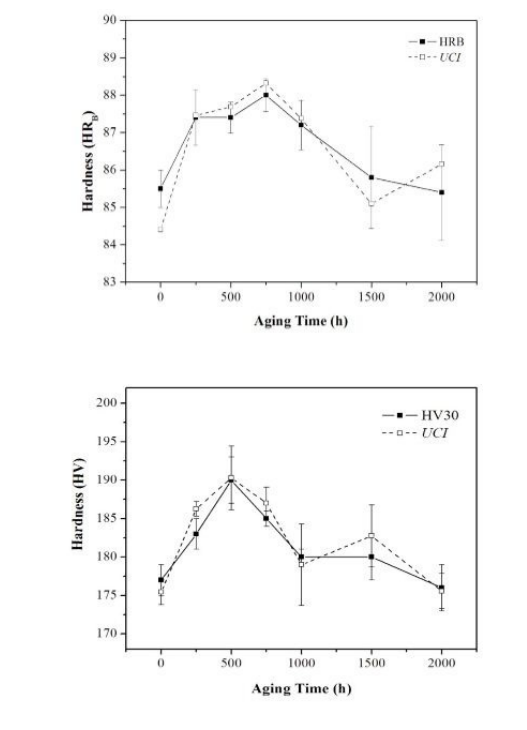
Figure 3. Comparison between Rockwell B and Vickers laboratory and field hardness values of solution treatment and isothermally aged samples at 600 ºC.